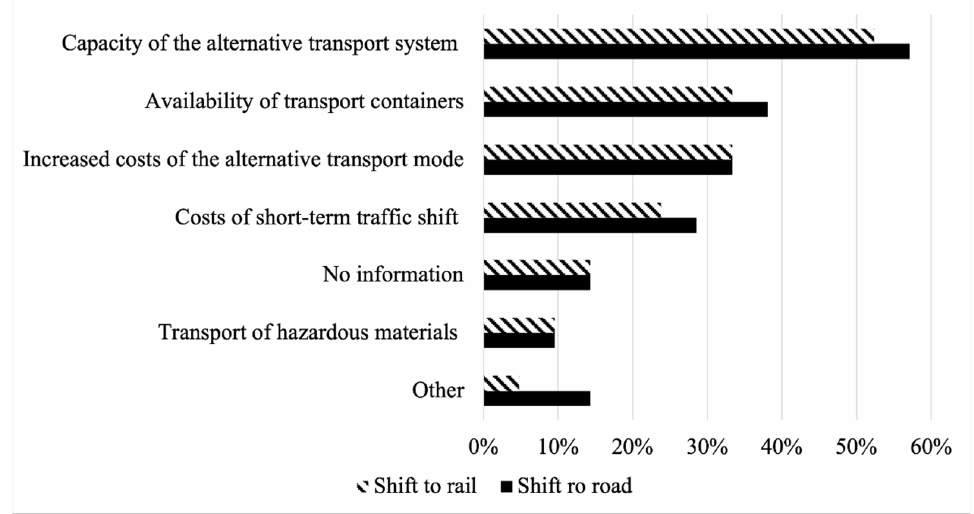
Figure 15. Barriers to modal shift.